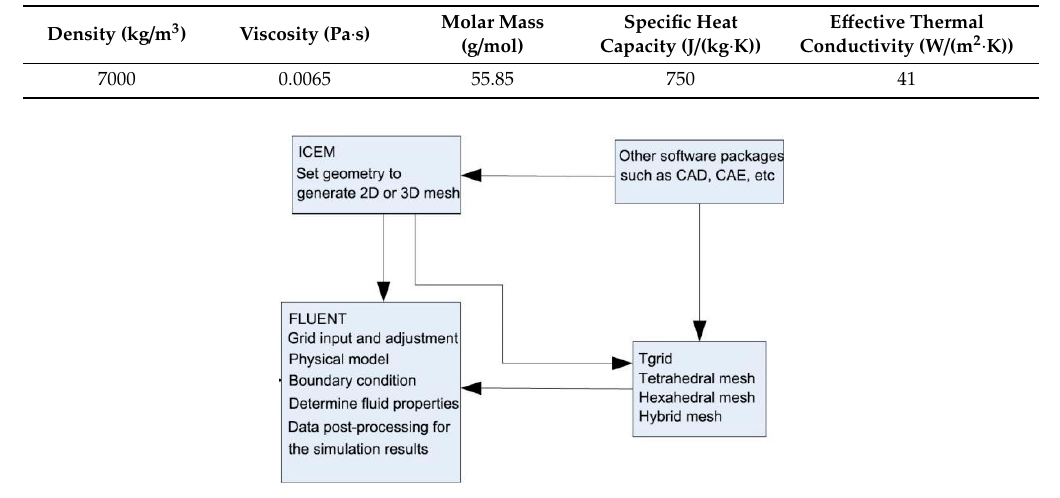
Figure 2. The process of building the FLUENT model. Table 2. Parameters for the mold.